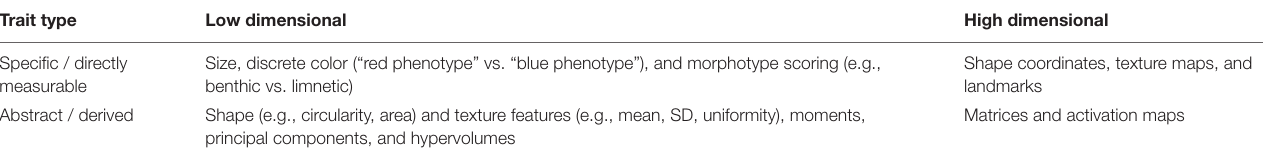
TABLE 1 | Classes of phenotypic data. Trait